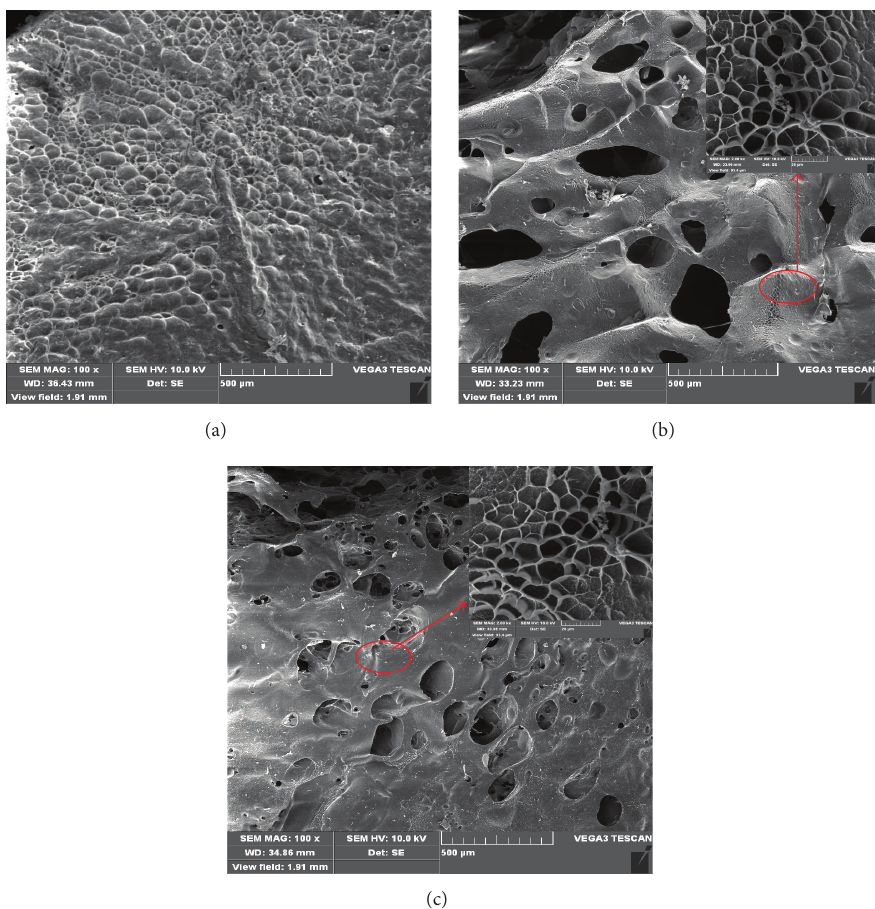
Figure 5: SEM images of the semi-IPN7 swollen in pH 2.0 (a), pH 7.4 (b), and pH 10.0 (c) buffer solutions.